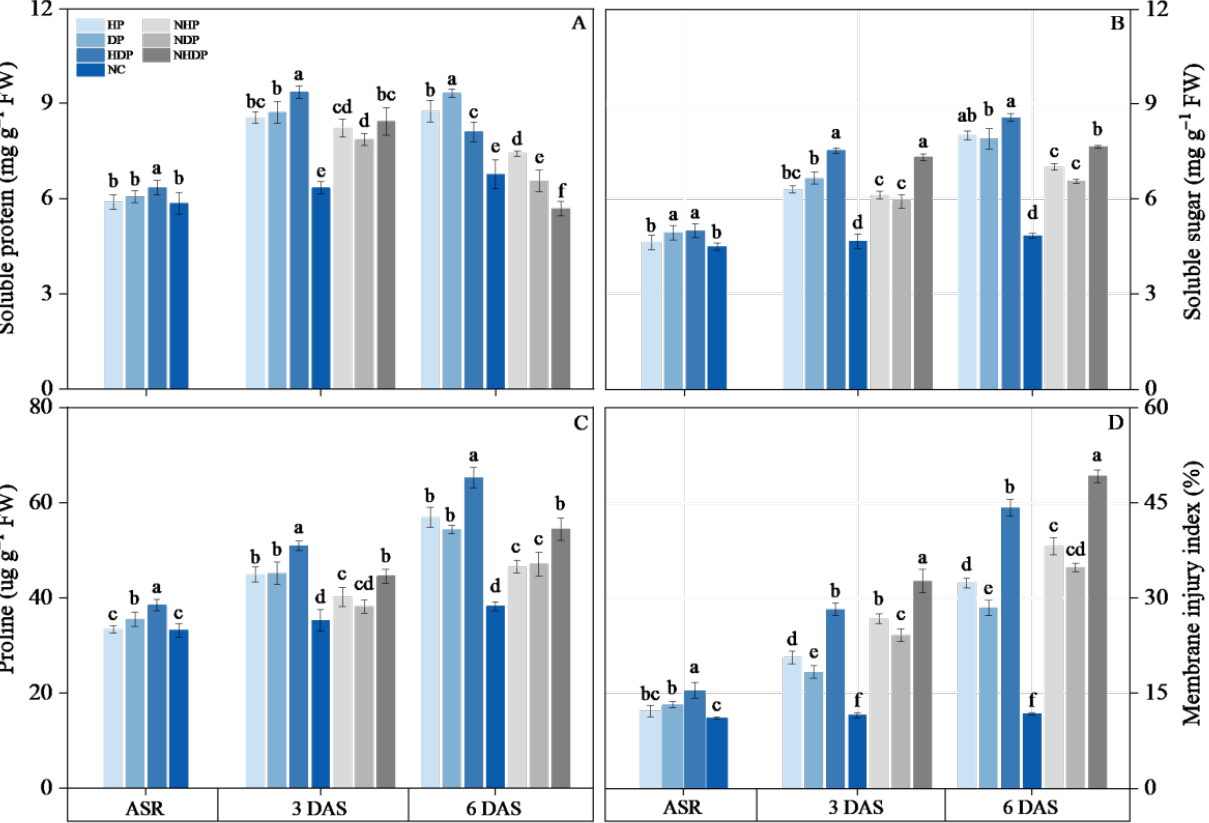
Figure 7. Effects of stress priming on soluble protein (SP, A ), soluble sugar (SS, B ), proline (Pro, C ) contents, and membrane injury index (MII, D ) of seedlings under stress conditions. HP, heat priming + later heat stress; DP, drought priming + later drought stress; HDP, combined stress priming + later combined stress; NHP, no heat priming + later heat stress; NDP, no drought priming + later drought stress; NHDP, no combined stress priming + later combined stress; NC, no stress priming + no later stress. The bars represent means ± SD (n = 5), where different letters designate significant differences at the 0.05 level.